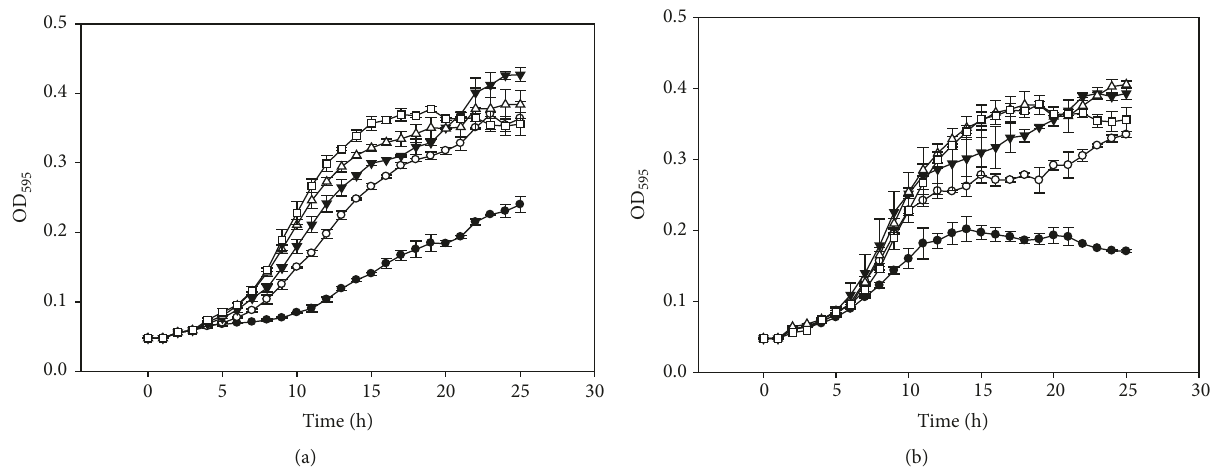
Figure 1: Benzoyl peroxide (a) and salicylic acid (b) activity against G. vaginalis . Benzoyl peroxide 250 𝜇 g/mL ( e ), 125 𝜇 g/mL ( I ), 62.5 𝜇 g/mL ( 󳶃 ), 31.3 𝜇 g/mL ( Δ ), and 0 𝜇 g/mL ( ◻ ). Salicylic acid 250 𝜇 g/mL ( e ), 125 𝜇 g/mL ( I ), 62.5 𝜇 g/mL ( 󳶃 ), 31.3 𝜇 g/mL ( Δ ), and 0 𝜇 g/mL ( ◻ ).